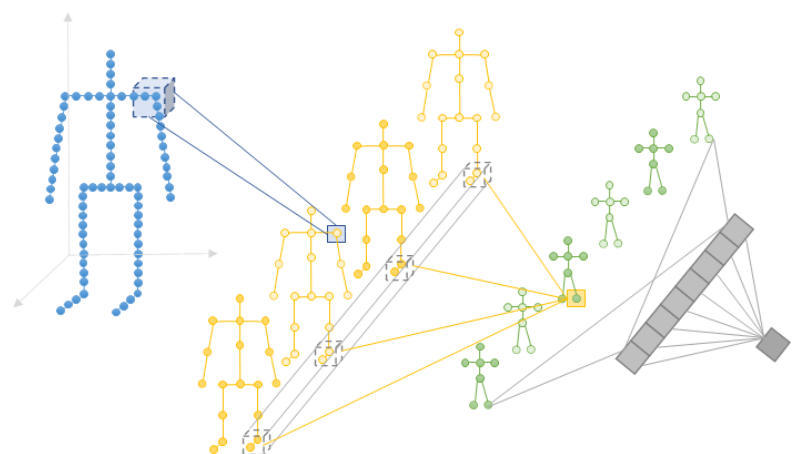
Figure 5. SC3D for skeleton feature